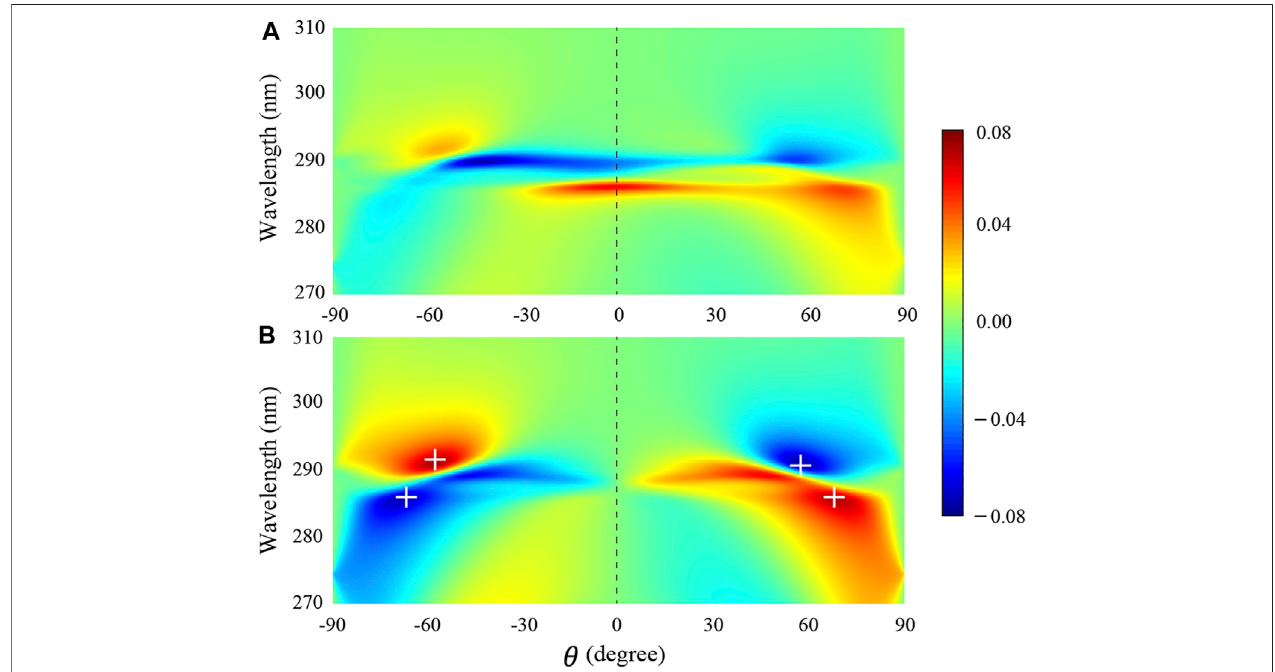
FIGURE 4 | (A) Dependence of Δ T 1 (cid:1) T | α (cid:1) 0 . 1 − T | α (cid:1) 0 on the incident angle θ and wavelength when a TM-polarized plane wave is incident on the composite structure M ( AB ) 3 . The dashed line denotes the position of θ = 0 ° . (B) Similar to (A) , but for the case of Δ T 2 (cid:1) T | α (cid:1) 0 . 1 − T | α (cid:1)− 0 . 1 . The maximum of | Δ T 2 | is marked by the white crosses.